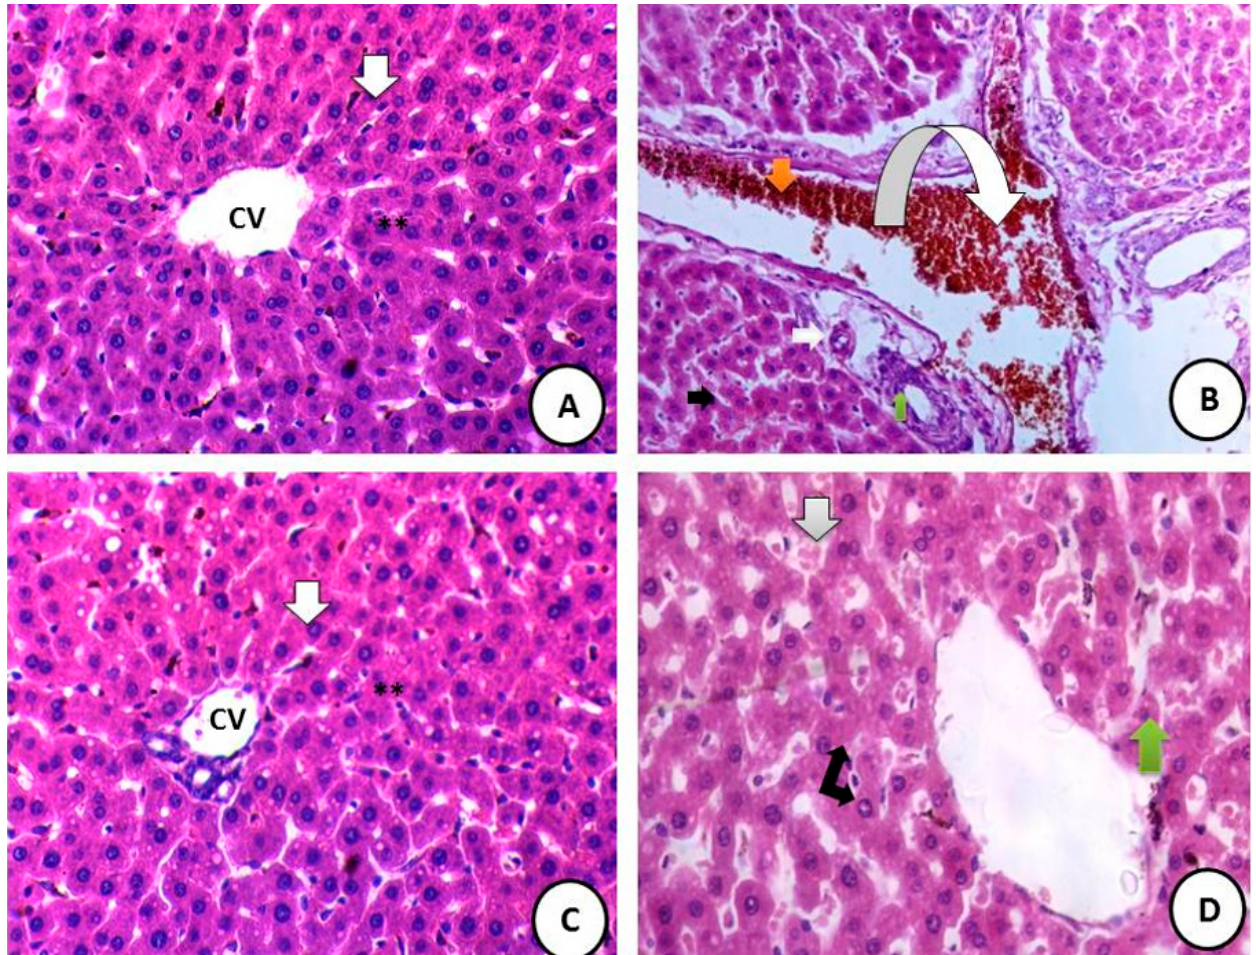
Figure 8. ( A ) Control group: photomicrograph of cross-section of the hepatic tissues showing normal hepatic structure (H & EX400). ( B ) Photomicrograph of cross-section of experimental rat liver after administration of CdCl 2 showing toxicity in the form of hypertrophy of hepatocytes with appearance of binucleated hepatocytes and increased eosinophilia (black arrow); the portal tract shows marked dilatation of the portal vein and radicles filled with hemorrhage (orange arrow); perivenular fibrosis around the portal vein, new bile duct formation at the periphery of the portal tract (ductular reaction) (white arrow); and fibrosis and hyalinization around blood vessels within the portal tract (green arrow) (H&EX 400). ( C ) Photomicrograph of cross-section of the hepatic tissues of Waste of Taif rose-treated group showing normal hepatic structure (H&EX 400). ( D ) Photomicrograph of